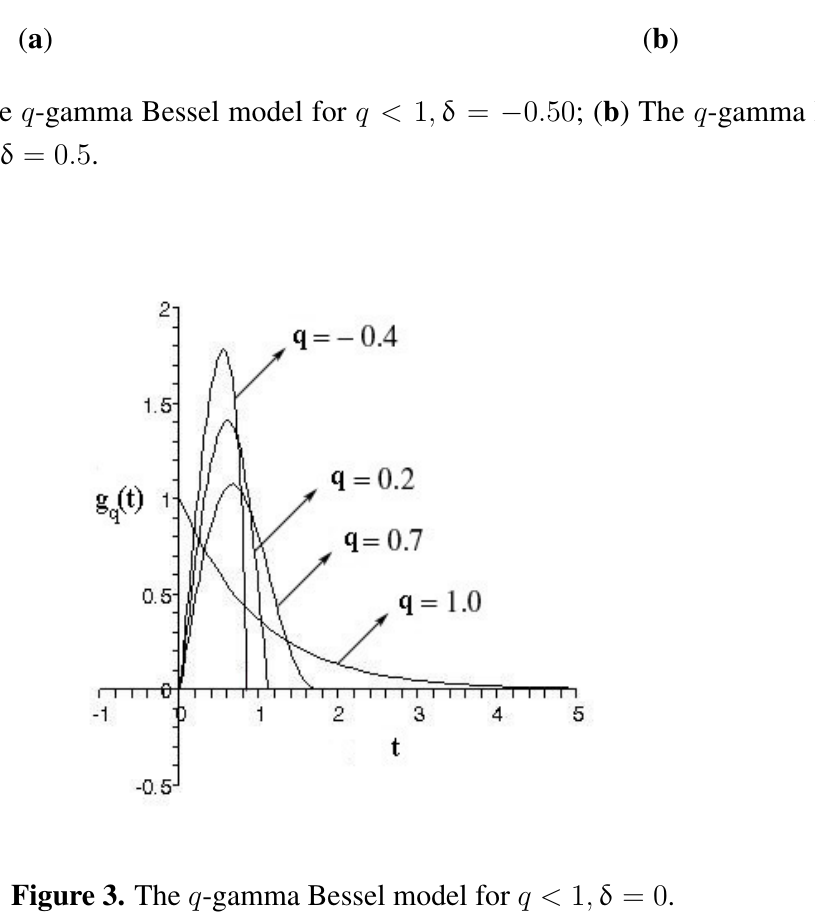
Figure 3. The q -gamma Bessel model for q < 1 , δ = 0